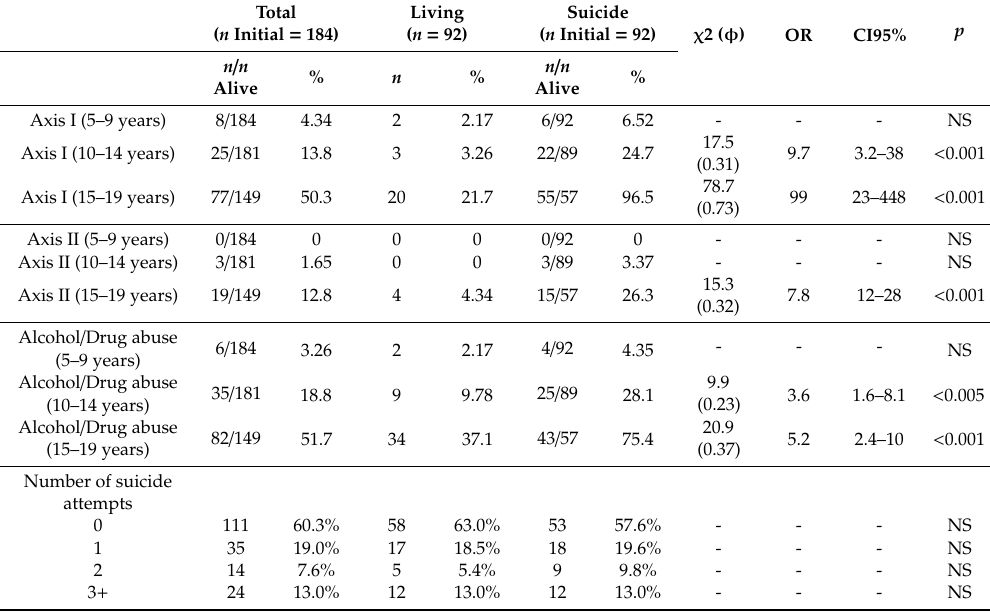
Table 4. Diagnoses and suicide attempts by age and groups.